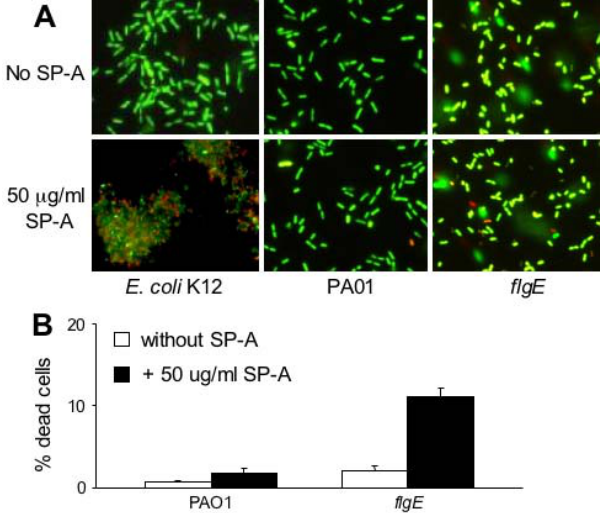
Figure 5. SP-A Directly Kills flgEby Membrane Permeabilization. (A) Live/dead staining was performed on E. coli K12, PA01 and flgE cells following incubation with 50 m g/ml SP-A. Green-stained cells are alive whereas red-stained cells are dead. Robust aggregation of E. coli K12 but not P. aeruginosa strains by SP-A was observed. (B) Enumeration of live or dead bacteria following a 1 h exposure to hSP-A. At least 1,000 bacterial cells were counted under a fluorescence microscope. The mean 6 SD of two experiments is shown.